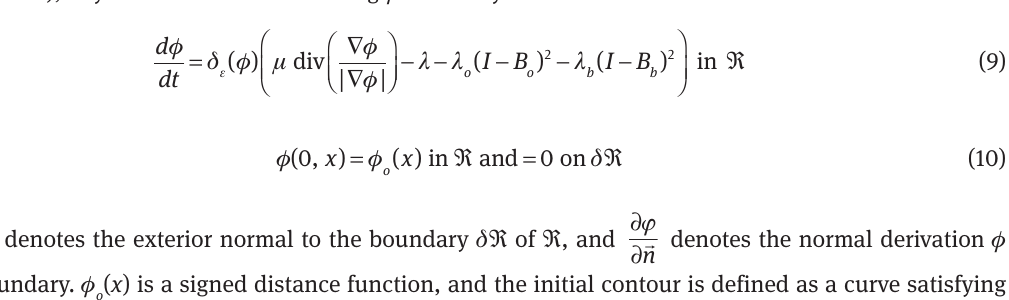
4 Algorithm Used for an Automatic